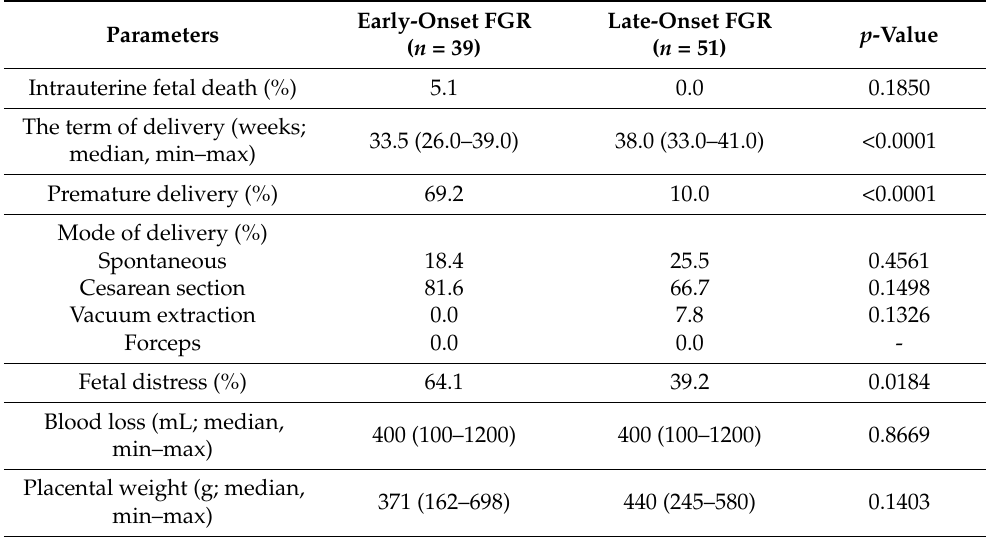
Table 5. The perinatal outcomes among women in pregnancy, complicated by the early-onset and late-onset FGR.